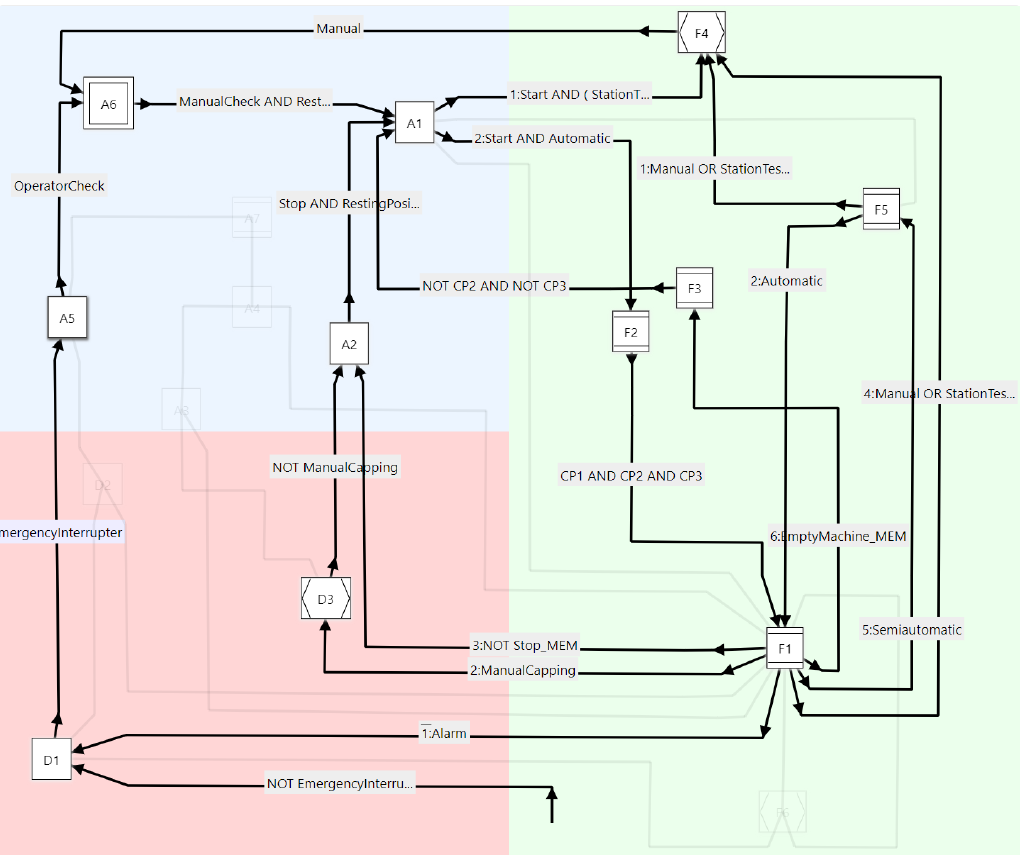
Figure 7. GG-Representation of the filling and encapsulating machine. It can be noticed that the steps and transitions not necessary for the case study are hidden and displayed in opaque